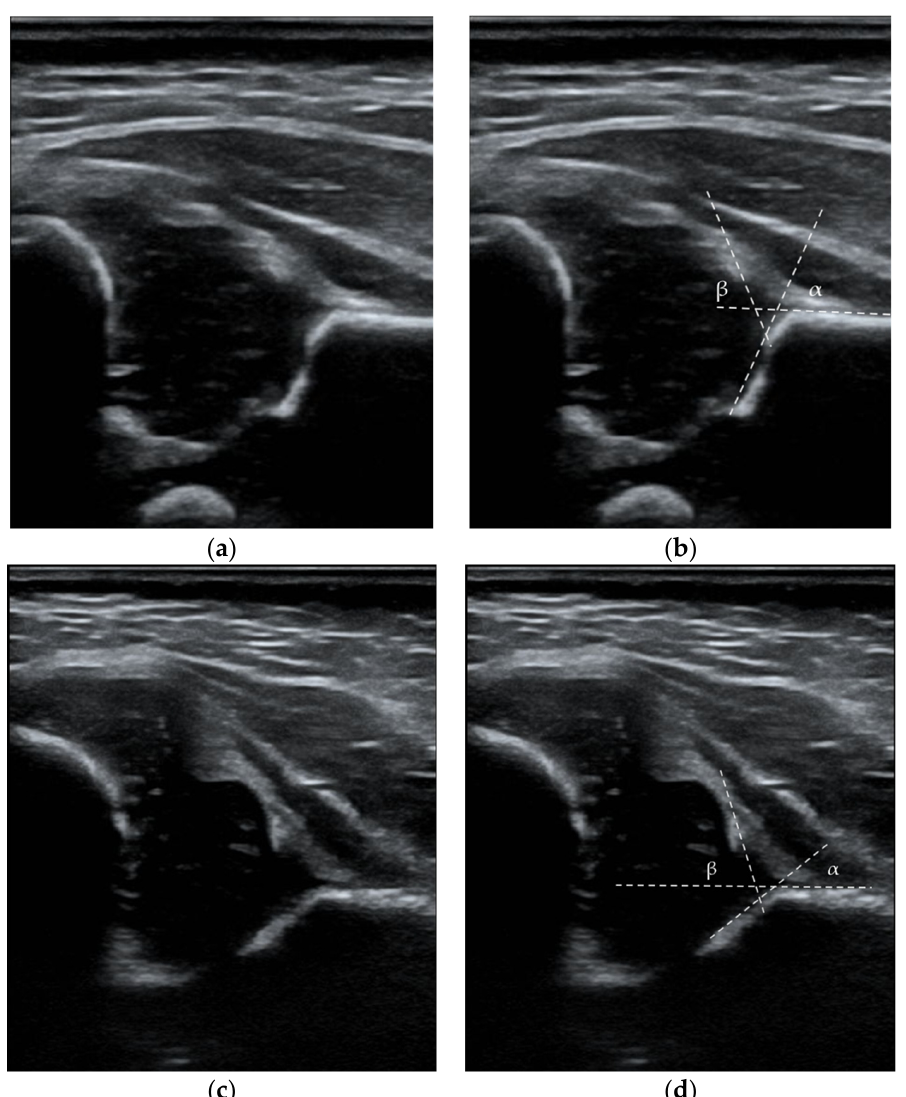
Figure 2. Ultrasound images with the measurements outlined: ( a , b ) Type IB, hip joint according to Graf, α = 68° β = 67°; ( c , d ) Type III, hip joint according to Graf, α = 42° β = 73°. White lines represent the base line, the bony roof line, and the cartilaginous roof line.